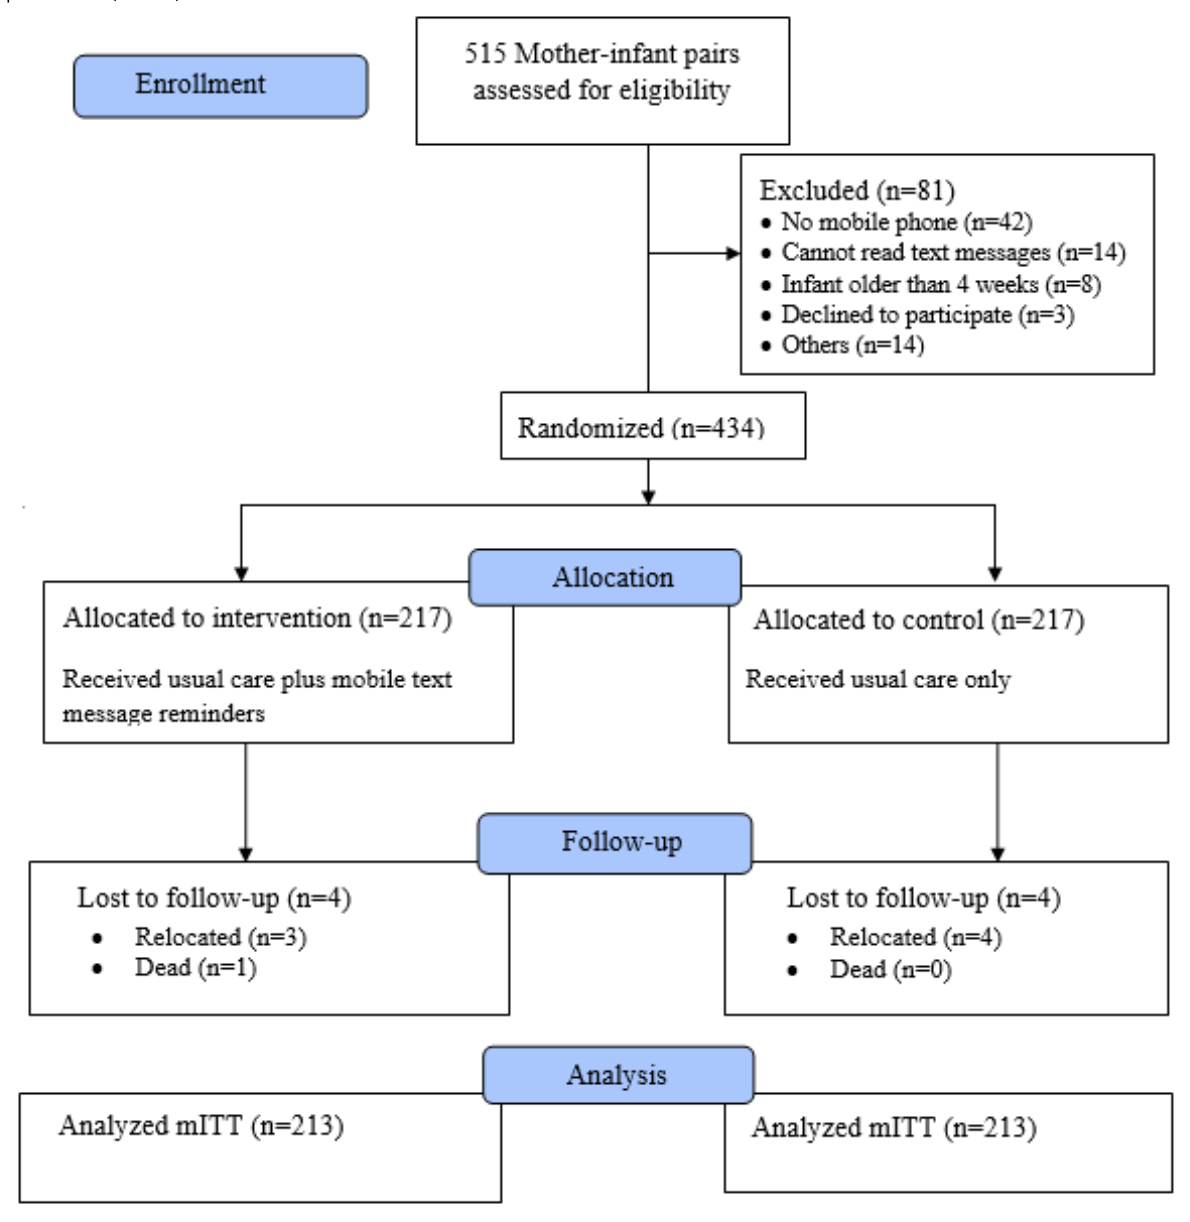
Figure 1. The CONSORT flow diagram of study participant enrollment, randomization, allocation, and analysis for the trial in Gondar city, northwest Ethiopia in 2020 (N=426). mITT: modified